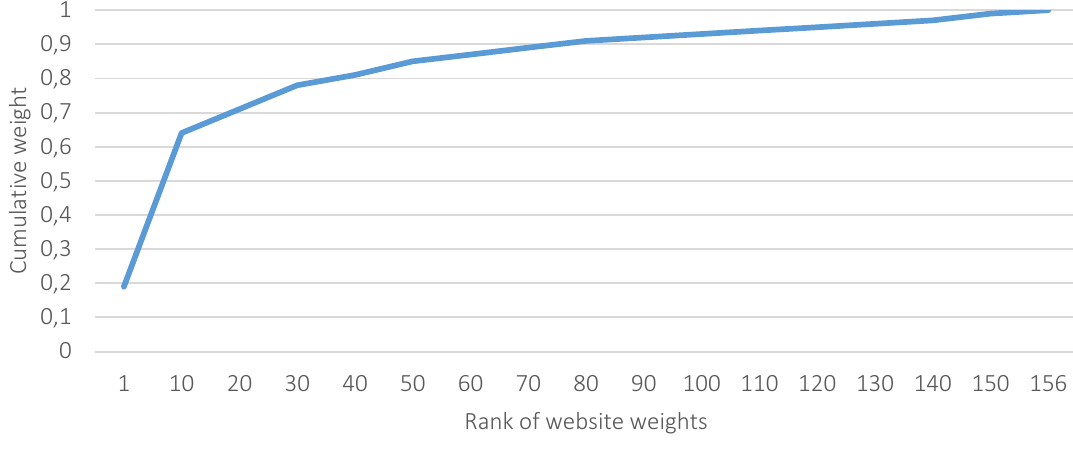
Figure 4. Cumulative distribution of website weight